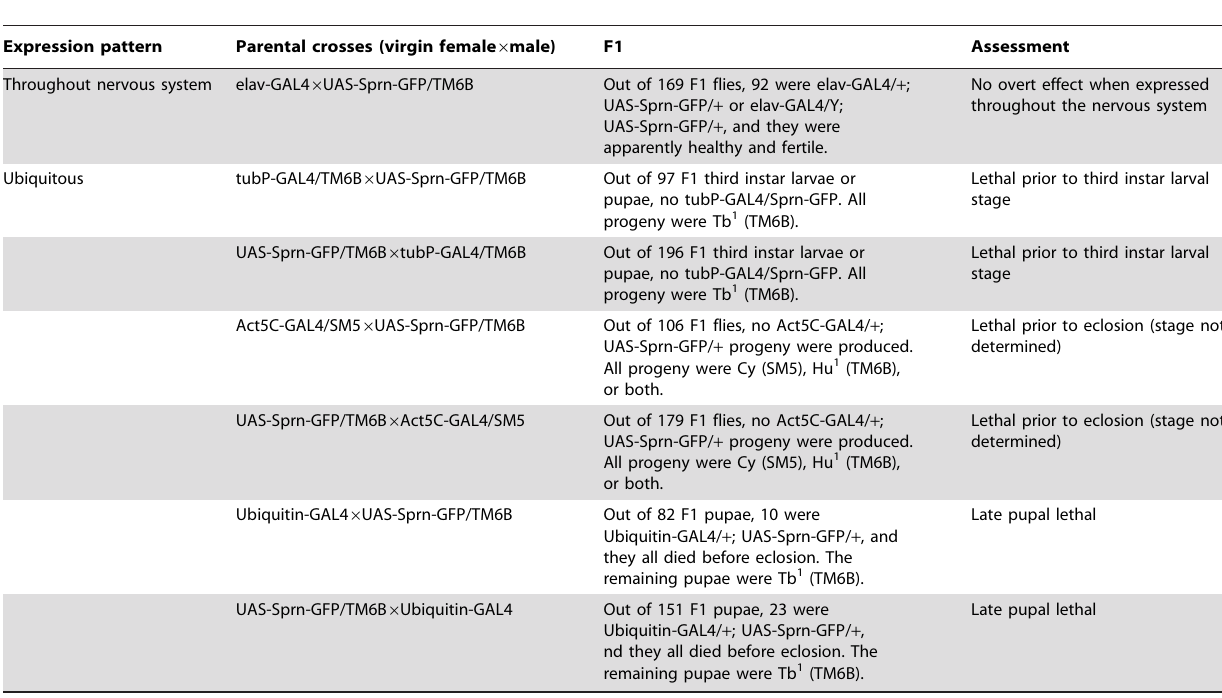
Expression pattern Assessment Throughout nervous system elav-GAL4 6